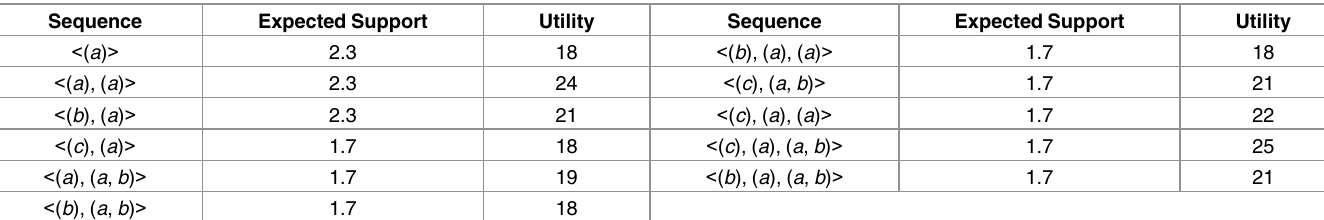
Table 3. The derived HUPSPs for the running